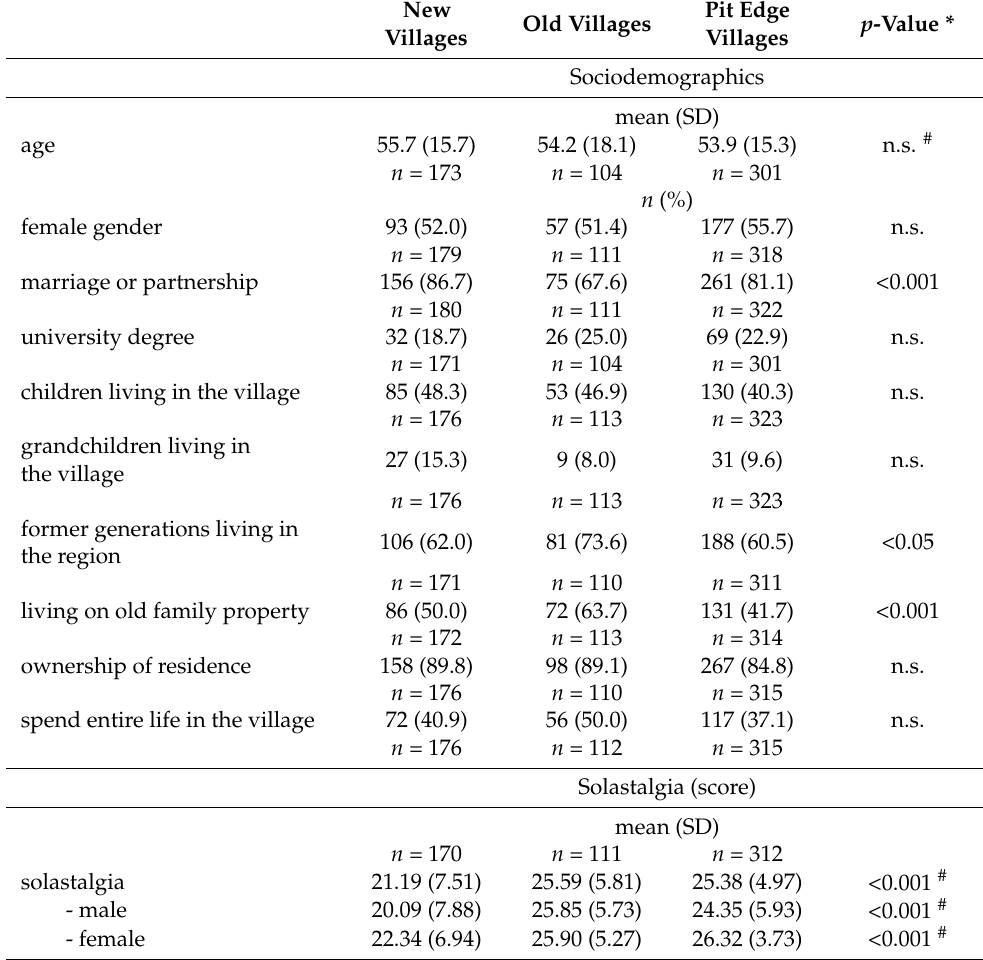
Table 2. Sociodemographics, Solastalgia and Patient Health Questionnaire Scores and Correlations.